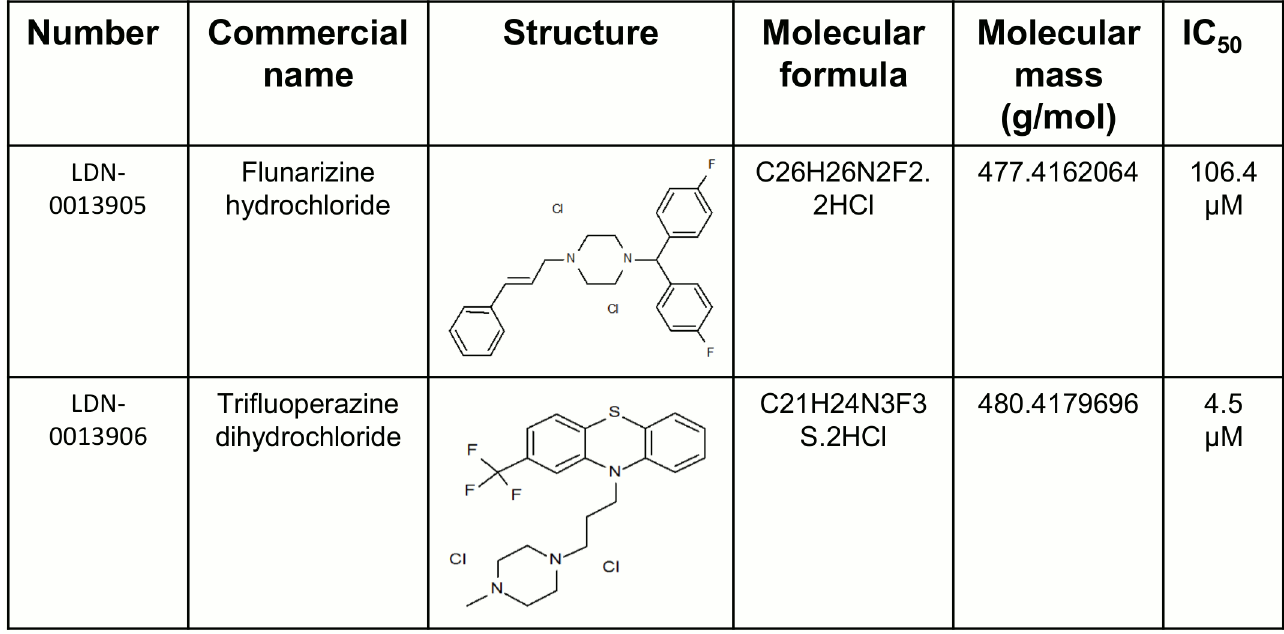
Fig 6. Chemical structure and formula of identified hits. Chemical structures, masses and formulas of the inhibitors are listed in the tabular